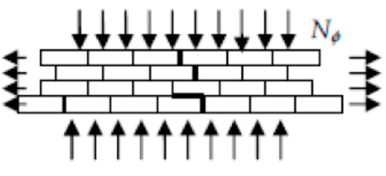
Figure 1. Friction increasing due to meridian compressions.